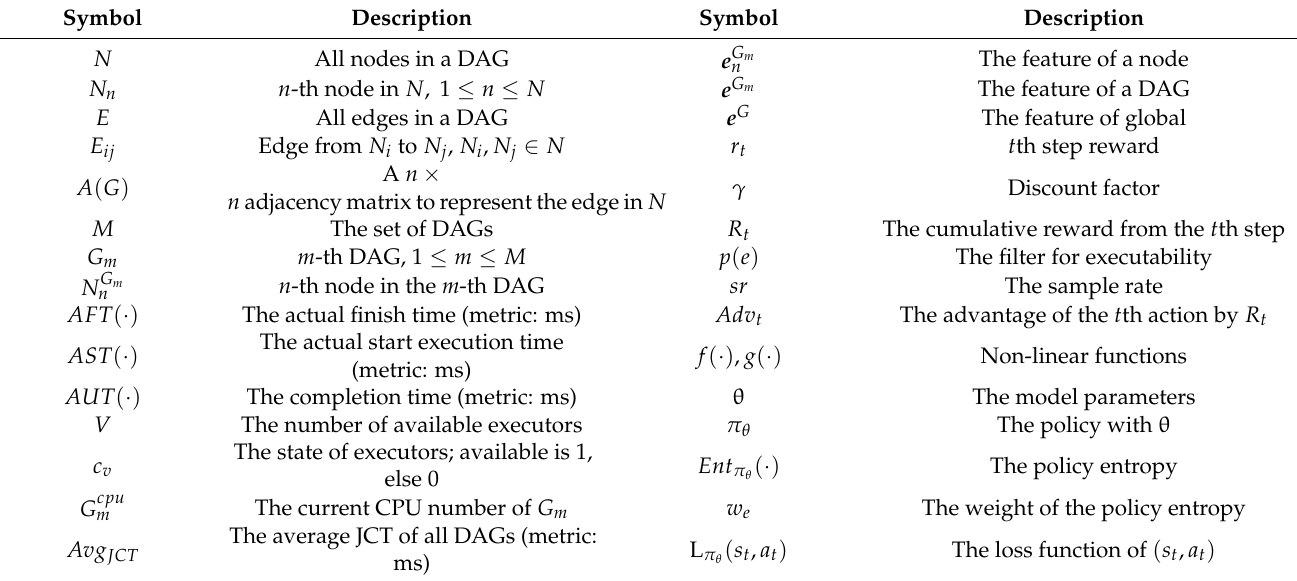
Table 1. Descriptions of symbols in DAG scheduling